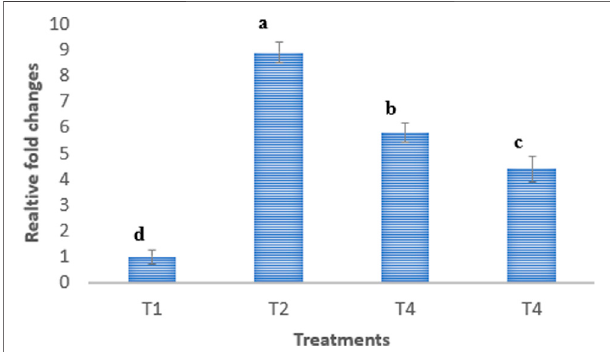
FIGURE 4 | Relative fold changes of C. jejuni population in ileum digesta.T1:normaldiet;T2:normaldiet+infectedby C.jejuni onday21;T3: Normal diet enriched by PRF (10 mg TPC/kg BW/day) + infected by C. jejuni on day 21; T4: Normal diet enriched by nanoliposome-encapsulated PRF (10 mg TPC/kg BW/day) + infected by C. jejuni on day